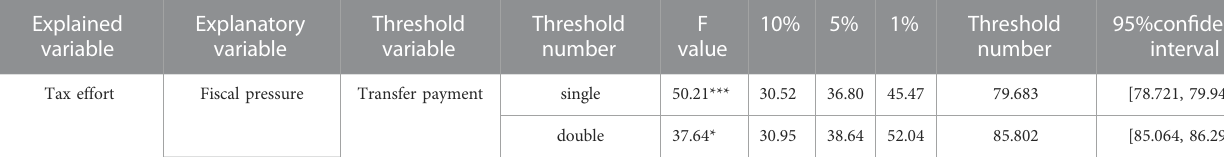
TABLE 6 Signi fi cance test and con fi dence interval of threshold variable transfer payment. Explained variable